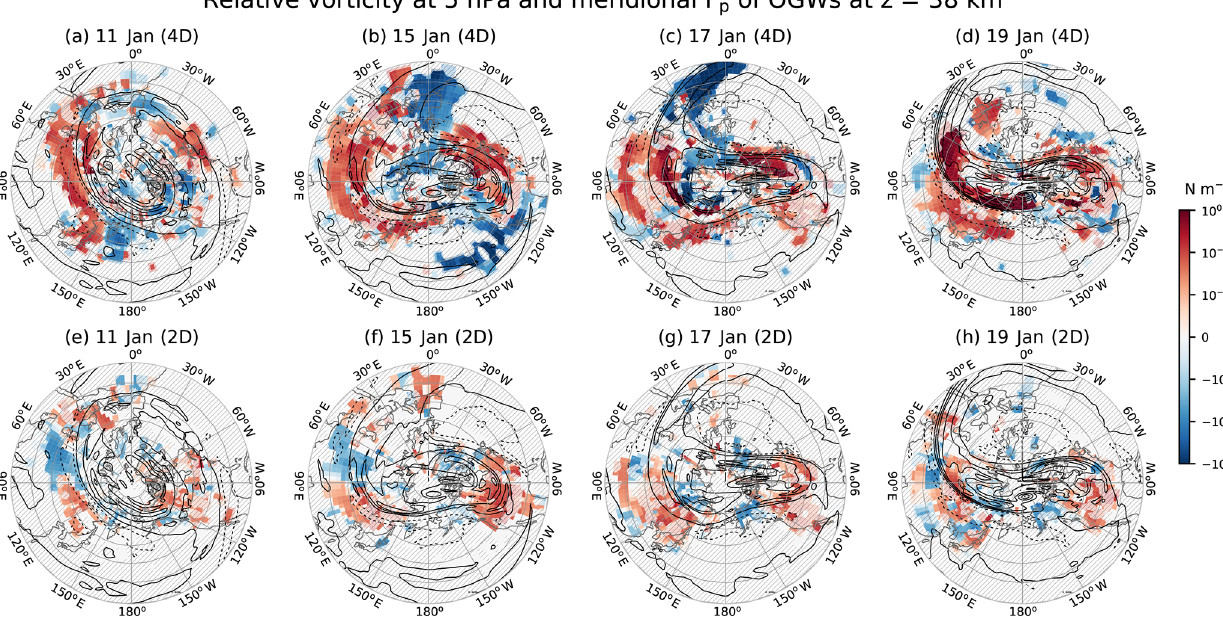
Figure 14. Same as Fig. 13 except for meridional pseudomomentum fluxes ( F p